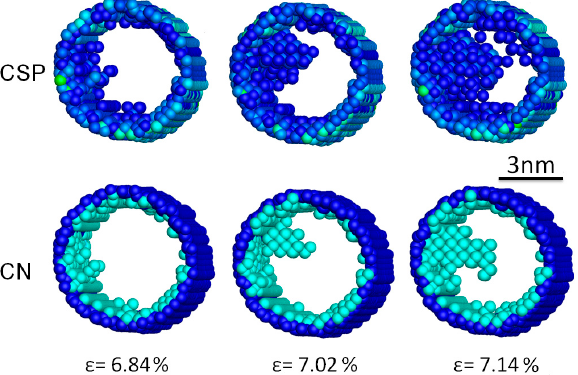
Figure 3. Evolution of dislocation (blue) shown by CSP and phase transformation (cyan) shown by CN at different strains.